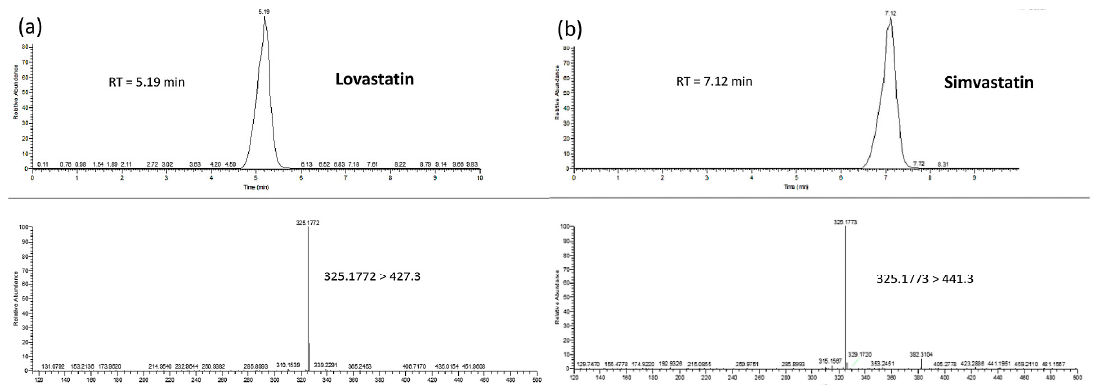
Figure 5. Representative chromatographs and mass spectra of Lovastatin ( a ) and Simvastatin (internal standard) ( b